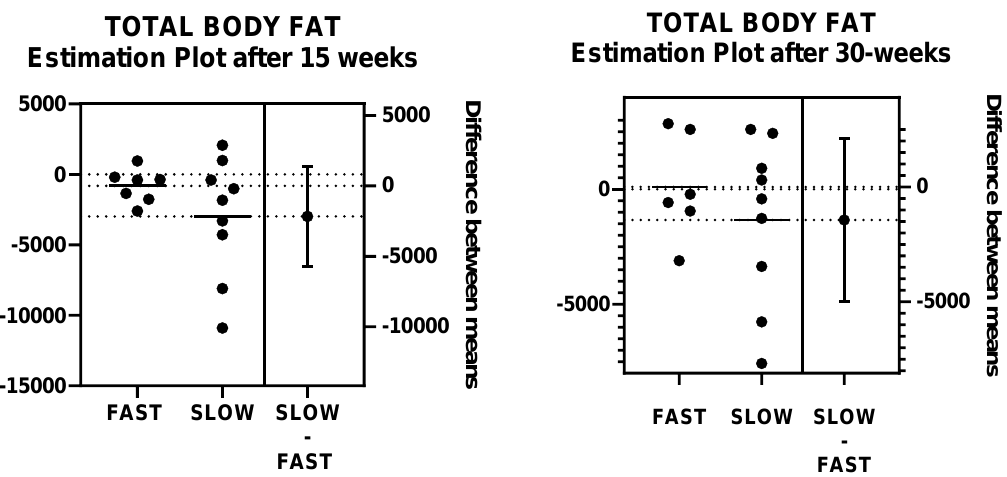
Figure 3. Estimation plots of total body fat as a function of walking speed after 15 and 30 weeks. The effects of walking speed on anthropometric SKF and Circ measurements of regional fat and lean body mass after 15 and 30 weeks of walking are shown in Table 6 and Figure 4. Individual SKF measurements revealed a similar pattern of fat gain for the abdomen and the sum of SKFs in slow walkers in both the 15-week and 30-week groups (15 w SKFs 1.7% and 1.5% gains, respectively, and 30 w 1.4% and 4.9% and 1.8% and 2.6% gains, respectively). By contrast, fast walkers showed opposite fat changes for abdominal SKFs and the sum of five SKF changes. Both the abdominal SKFs and the sum of SKFs decreased by 2.7% and 1.5%, respectively, in 15-week fast walkers. In 30-week fast walkers, the 30-week fat loss was estimated to be 1.4% for the abdomen and 3.9 and 2.4% for the sum of SKFs after 15 and 30 weeks of walking. Abdominal, gluteal, and thigh Circs showed no differential effect of speed, and all displayed losses after both 15 weeks and 30 weeks of walking. They were abdominal, gluteal, and thigh Circs, all showing between 0.3 and 3% declines. Upper arm Circs reflected changes in SC fat, while changes in the calf Circ likely reflected changes in LBM as the calves were engaged in walking. In the 15-week group, upper arm Circ did not change in slow walkers and decreased by 0.9% in the fast walkers. In the 30-week group after 15 and 30 weeks of walking, upper arm Circ decreased by 1% and 0.9% by week 30. Calf Circ, on the other hand, increased in the 15-week group at both the slow (1.4%) and fast (2.5%) speeds. Corresponding increases in calf Circ in the 30-week group were 3.2%% and 0.2% after 15 and 30 weeks of slow walking, and 1.9 and 2.7% after corresponding durations of fast walking. LBM did not change in the 15-week group in total body, percent body, and percent arm and leg values, regardless of the speed. However,